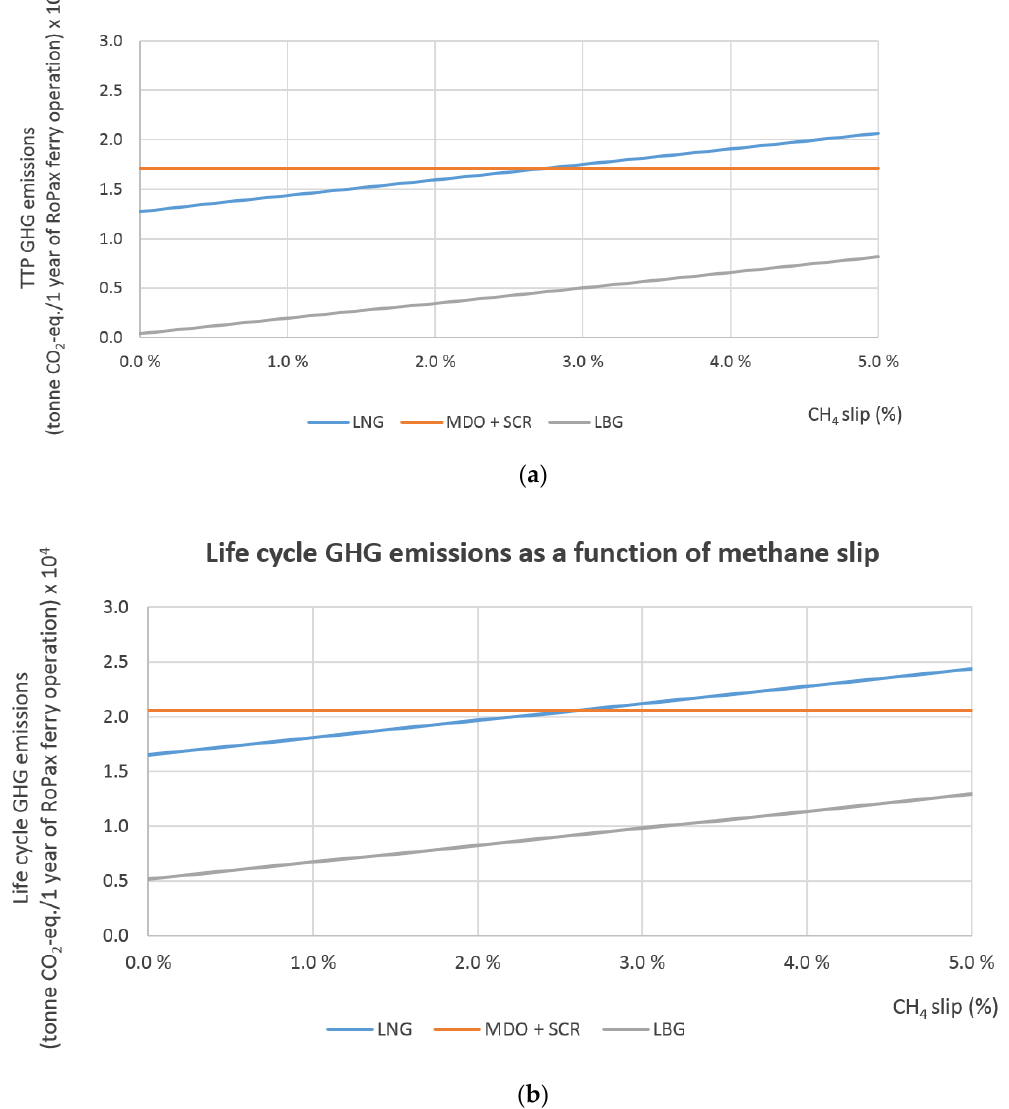
Figure 4. ( a ) Tank-to-propeller and ( b ) life cycle GHG emissions (in metric tons CO 2 -eq./year) as a function of CH 4 slip from the dual-fuel engine.